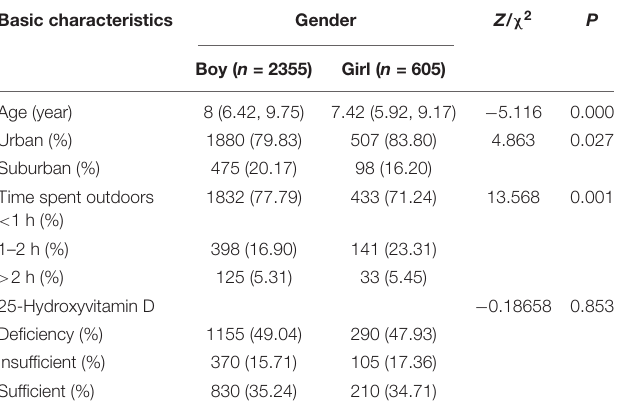
TABLE 1 | Basic characteristics of the TD